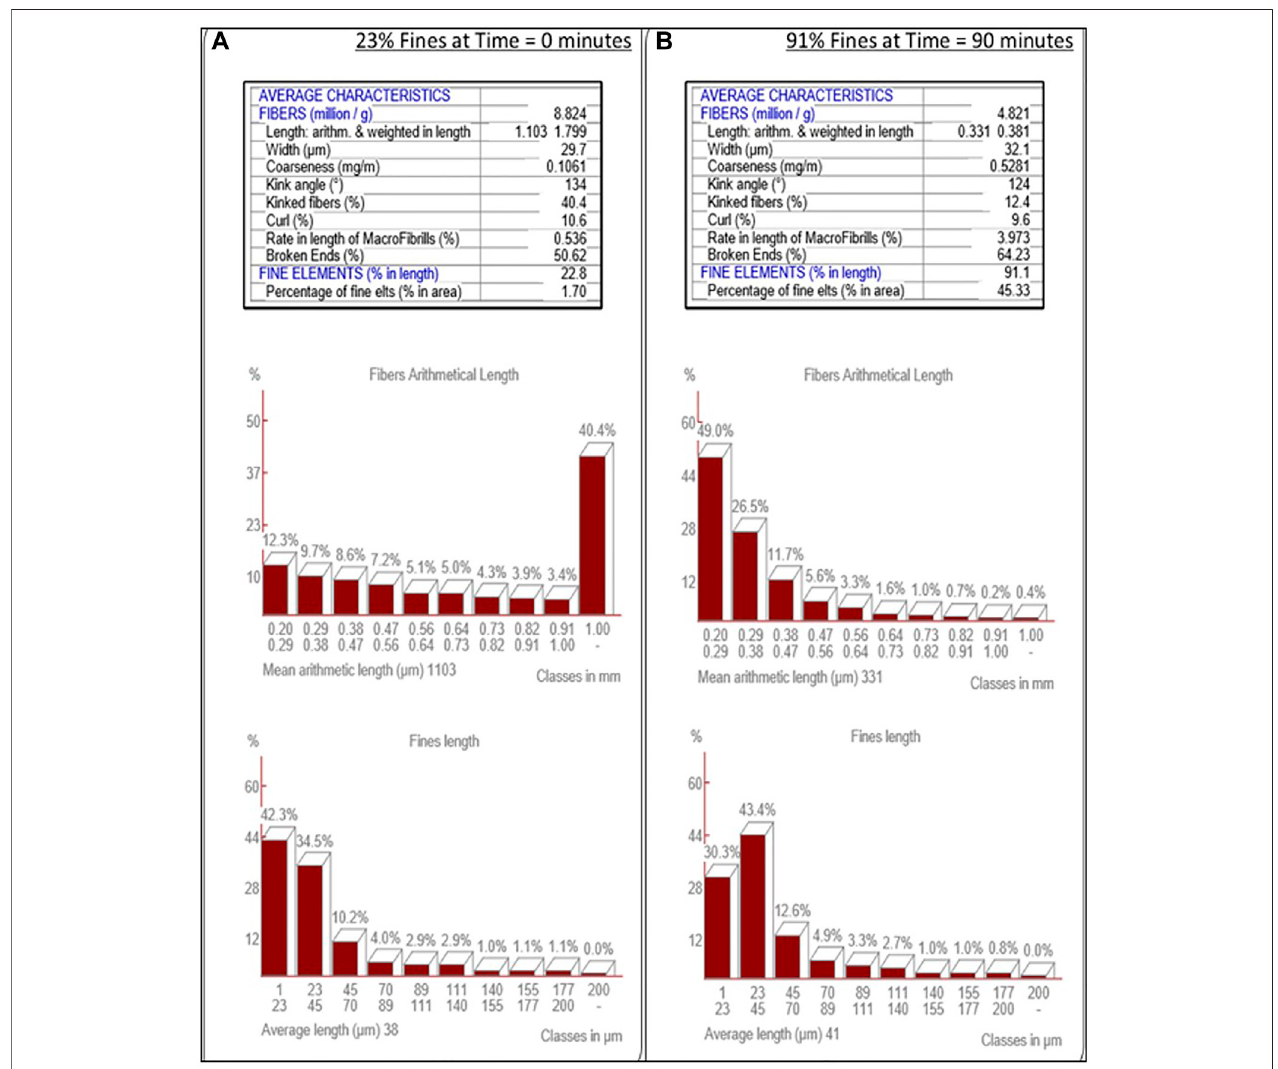
FIGURE 3 | MorFi Fiber Characteristic Analysis. MorFi fi ber analysis of the transition of fi ber into fi nes through re fi nement of wood pulp (A) into cellulose nano fi bers (B) .